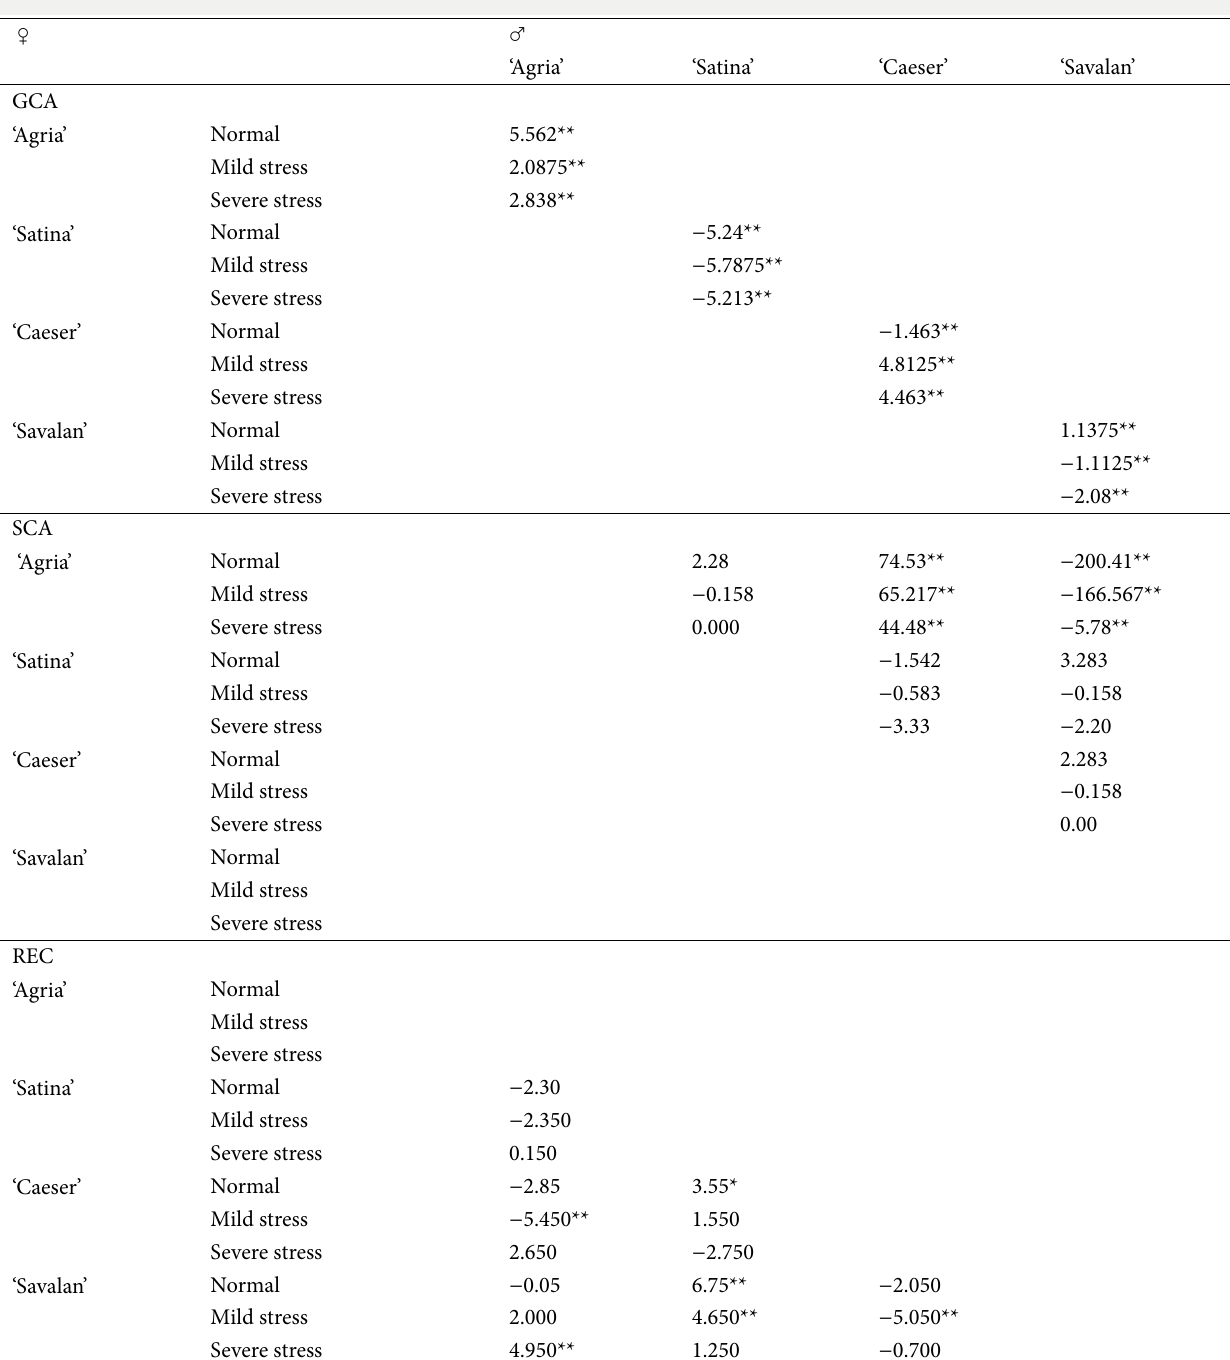
Table 4 Estimation of general combining ability (GCA), specific combine ability (SCA), and inverse (REC) potato tuber yield in normal, mild, and severe water stress